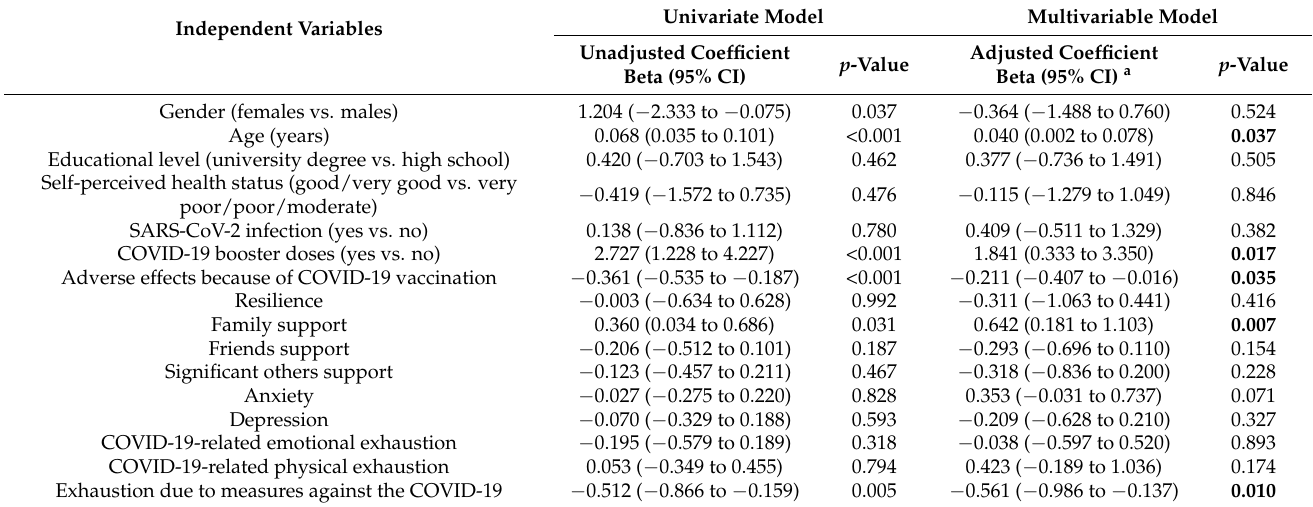
Table 3. Univariate and multivariable linear regression analysis with influenza vaccination willing- ness score as the dependent